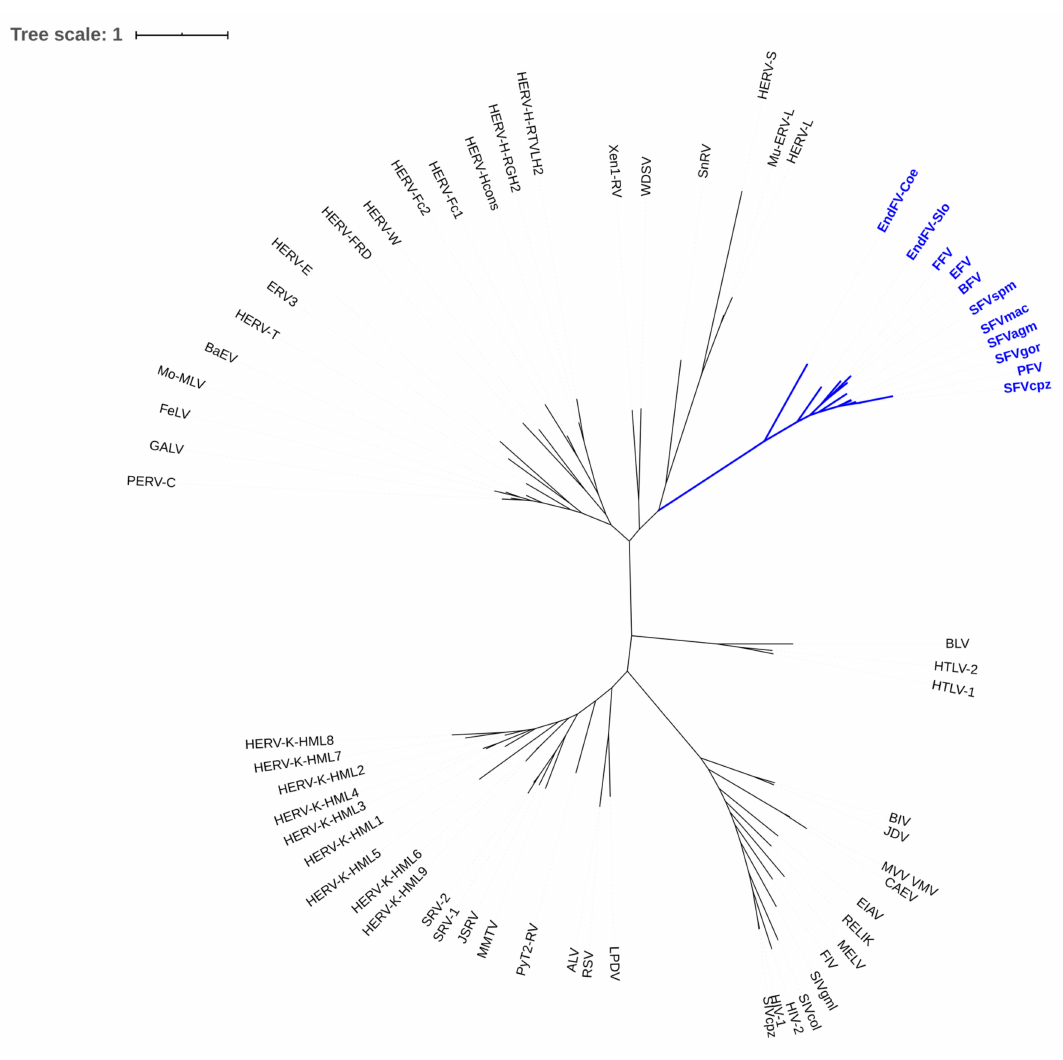
Figure 1. Phylogenetic tree of known exogenous and endogenous foamy viruses (FVs) (blue branches) and members of the Orthoretrovirinae . A fasta file with the conserved regions of the Pol proteins (supplement from ref. [2] and prototype FV (PFV, U21247.1) was used for alignment with